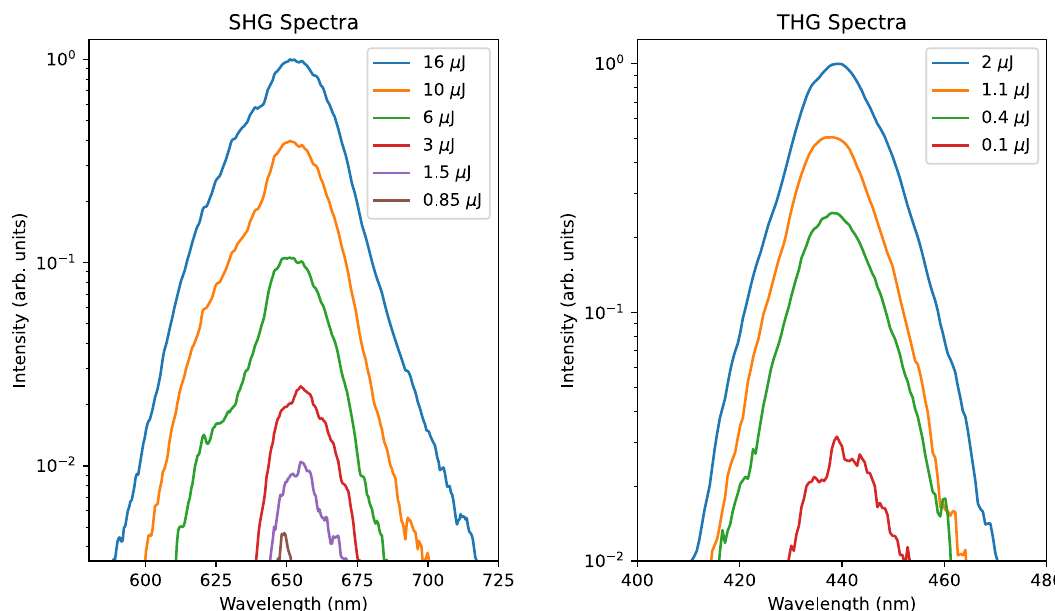
Fig. 7 SH and TH sensitivity analysis in NZI fi lms. SH (left) and TH (right) spectra at various input pulse energies from AZO fi lms. All curves are reported at zero delay from the FROG traces. SH plots start at energies as low as 850 nJ, while TH plots start at 100